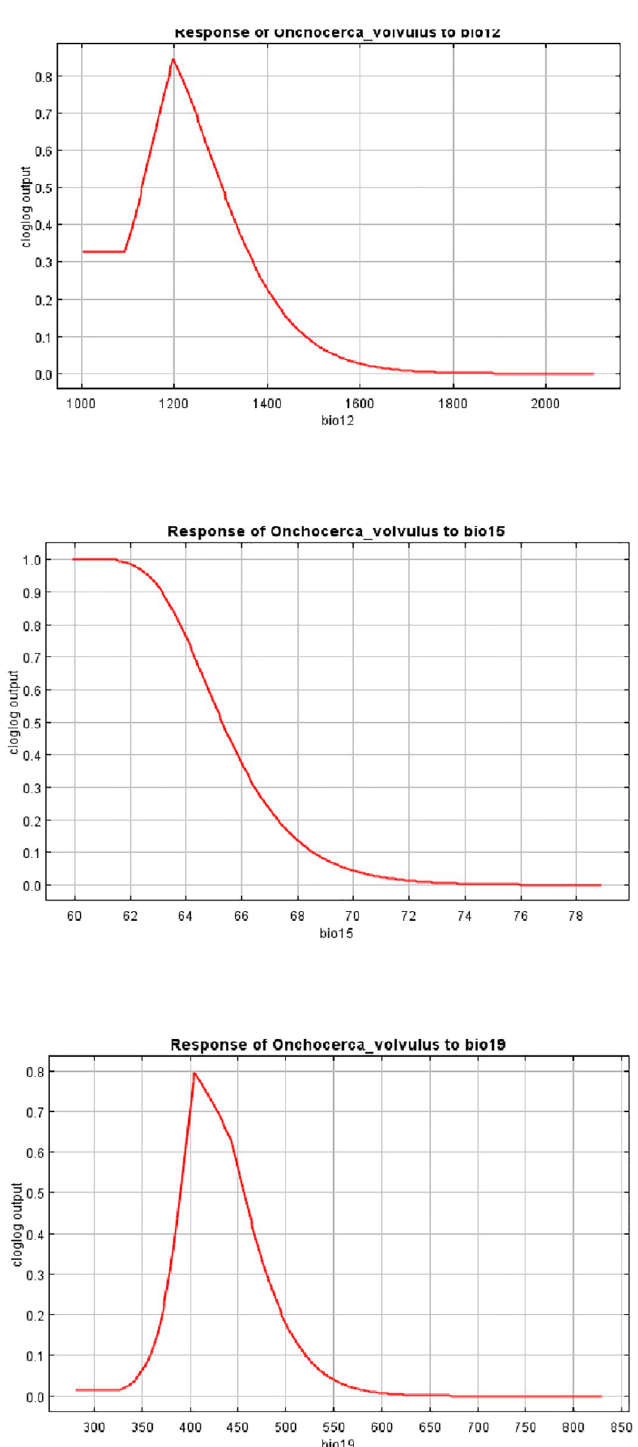
Fig 8. Response curves of three environmental predictors used in MaxEnt model for O . volvulus .